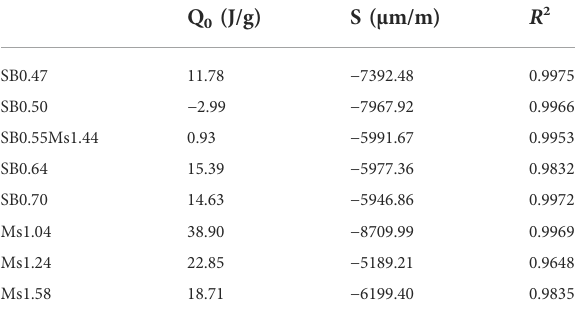
TABLE 5 Fitting parameters Q 0 and S together with the quadratic correlation coef fi cient R 2 to describe the linear relation between autogenous strain and cumulative heat